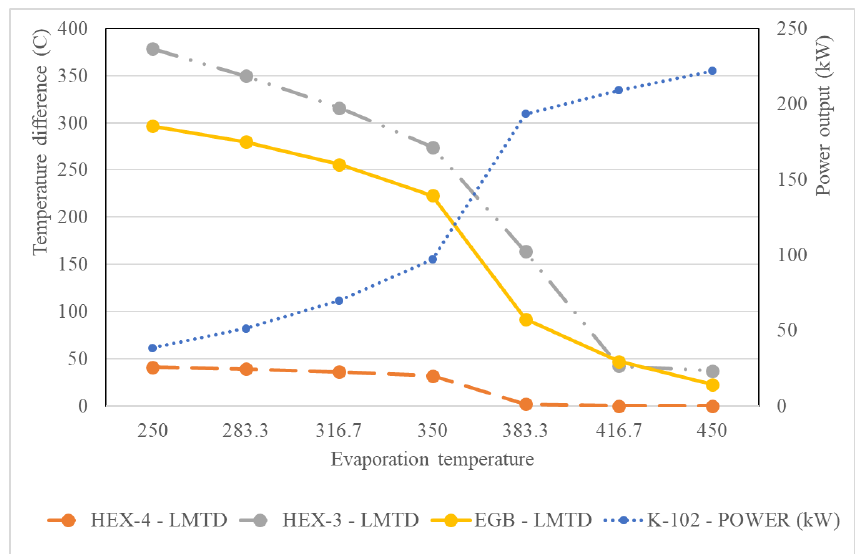
Figure 7. Effect of superheat temperature on SRC performance and heat exchanger efficiencies.